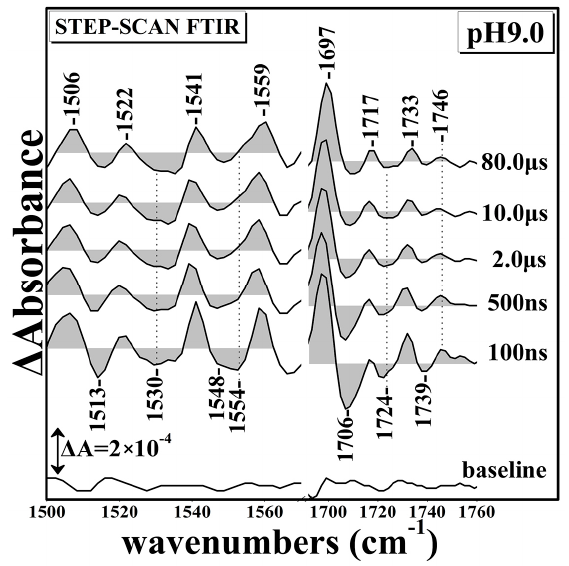
Figure 3. Time Resolved Step-Scan Fourier Transform Infrared (TRS 2 -FTIR) difference spectra of 1500–1760 cm − 1 region ( t d = 100–80,000 ns, 4 cm − 1 spectral resolution) of fully-reduced ba 3 -CO